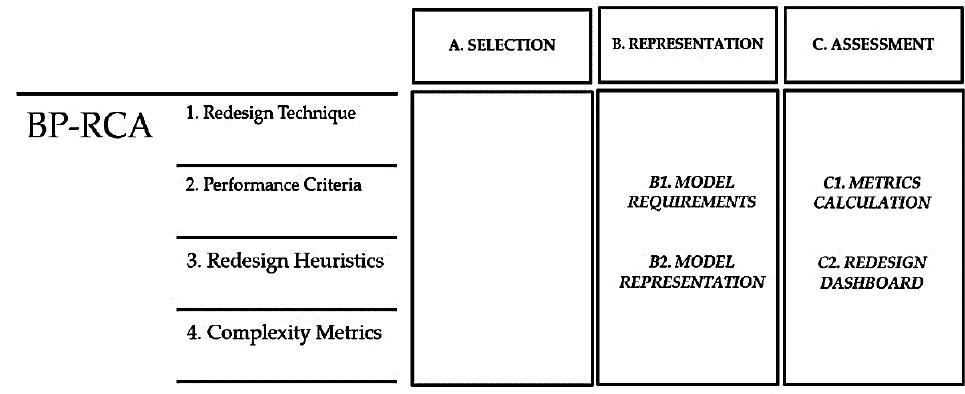
Figure 1. Overview of the BP-RCA framework.